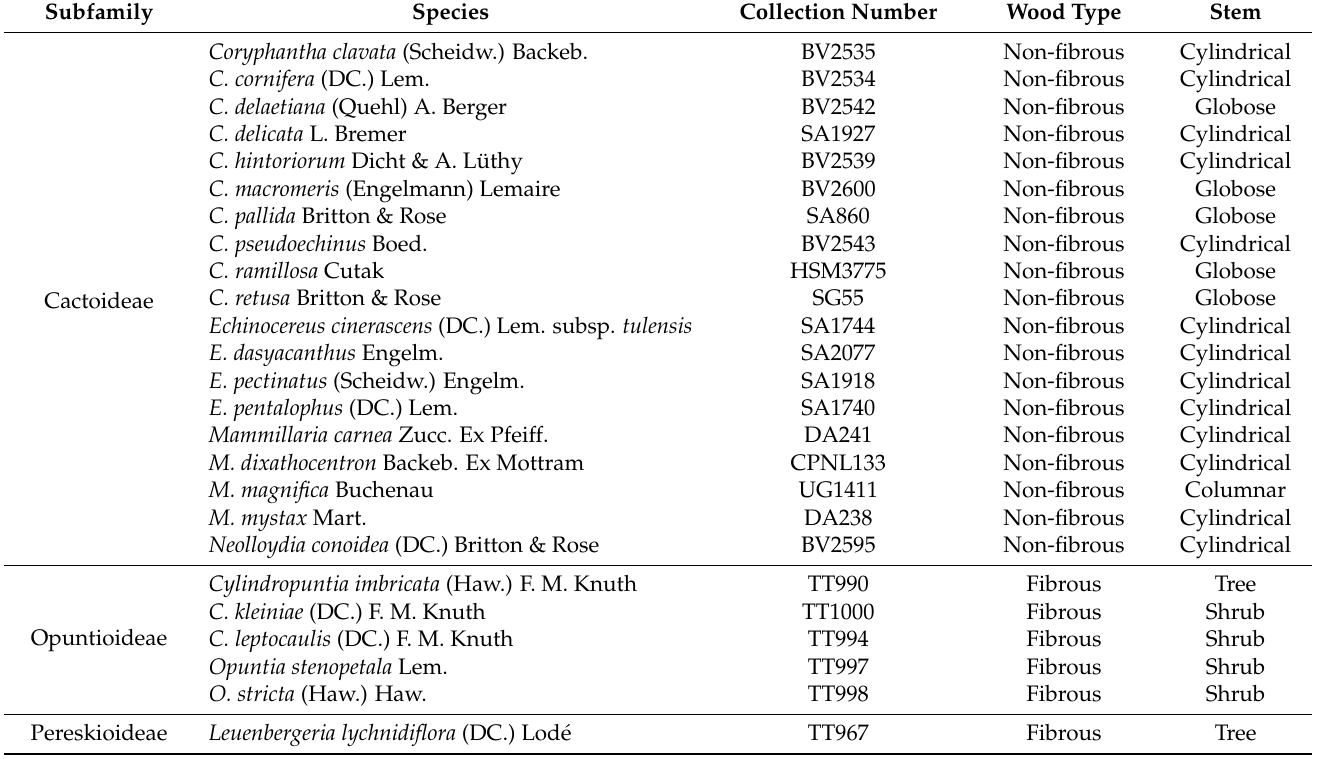
Table 1. Morpho-anatomical characteristics of the 25 species of